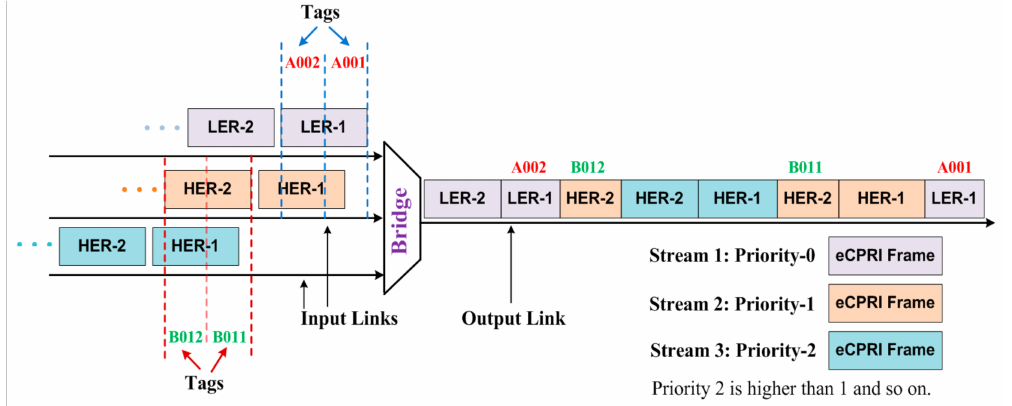
Figure 3. Frame preemption mechanism for enhanced common public radio interface (eCPRI) streams in the Ethernet-based fronthaul bridged networks